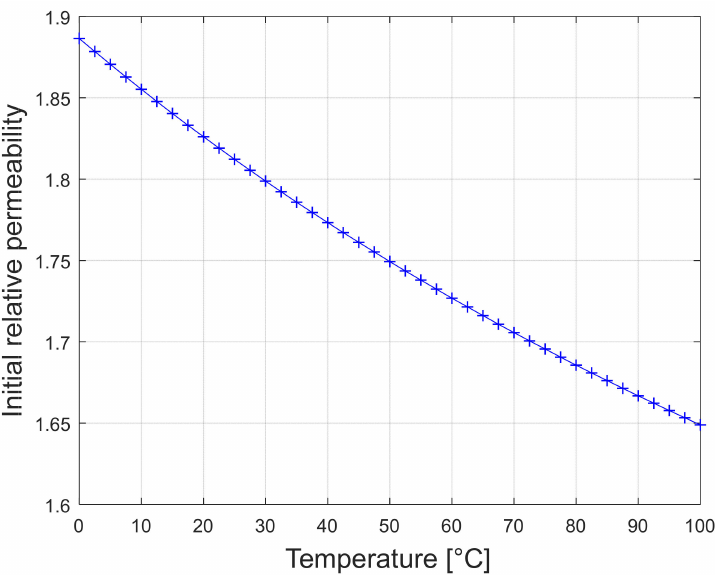
Figure 9. Temperature dependence of the initial relative permeability of the magnetic fluid. On the face region (Figure 3) around the container, the emissivity (value of 0.93) and absorption (value of 0.2) coefficients (for radiation), and convection coefficient (value of 10 W/m 2 K) were defined. These were used to simulate radiation and natural convection